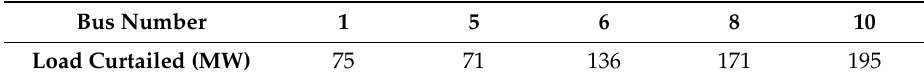
Table 9. The distribution of load shedding.